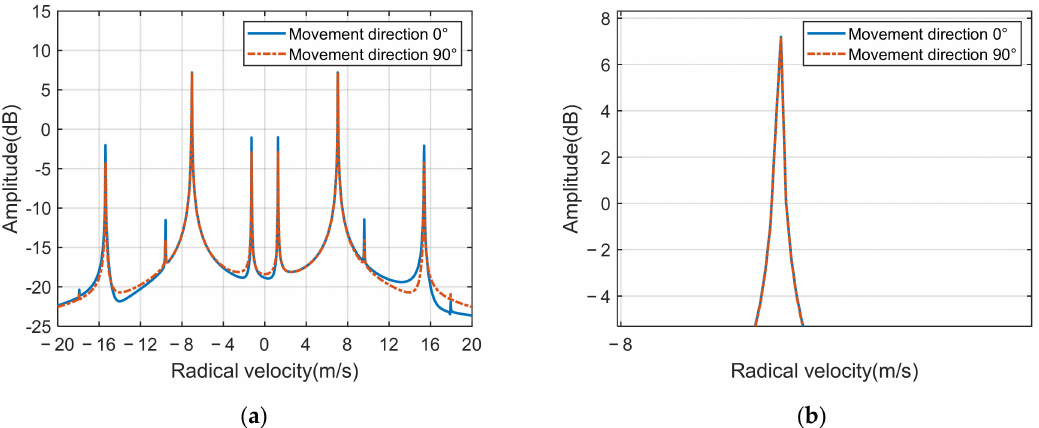
Figure 9. Simulated first-order Doppler spectra when the transmitting and receiving platforms undertake the same oscillation motions. ( a ) First-order Doppler spectra of two oscillation directions. ( b ) Zoomed-in view of the negative Bragg peak in ( a ).